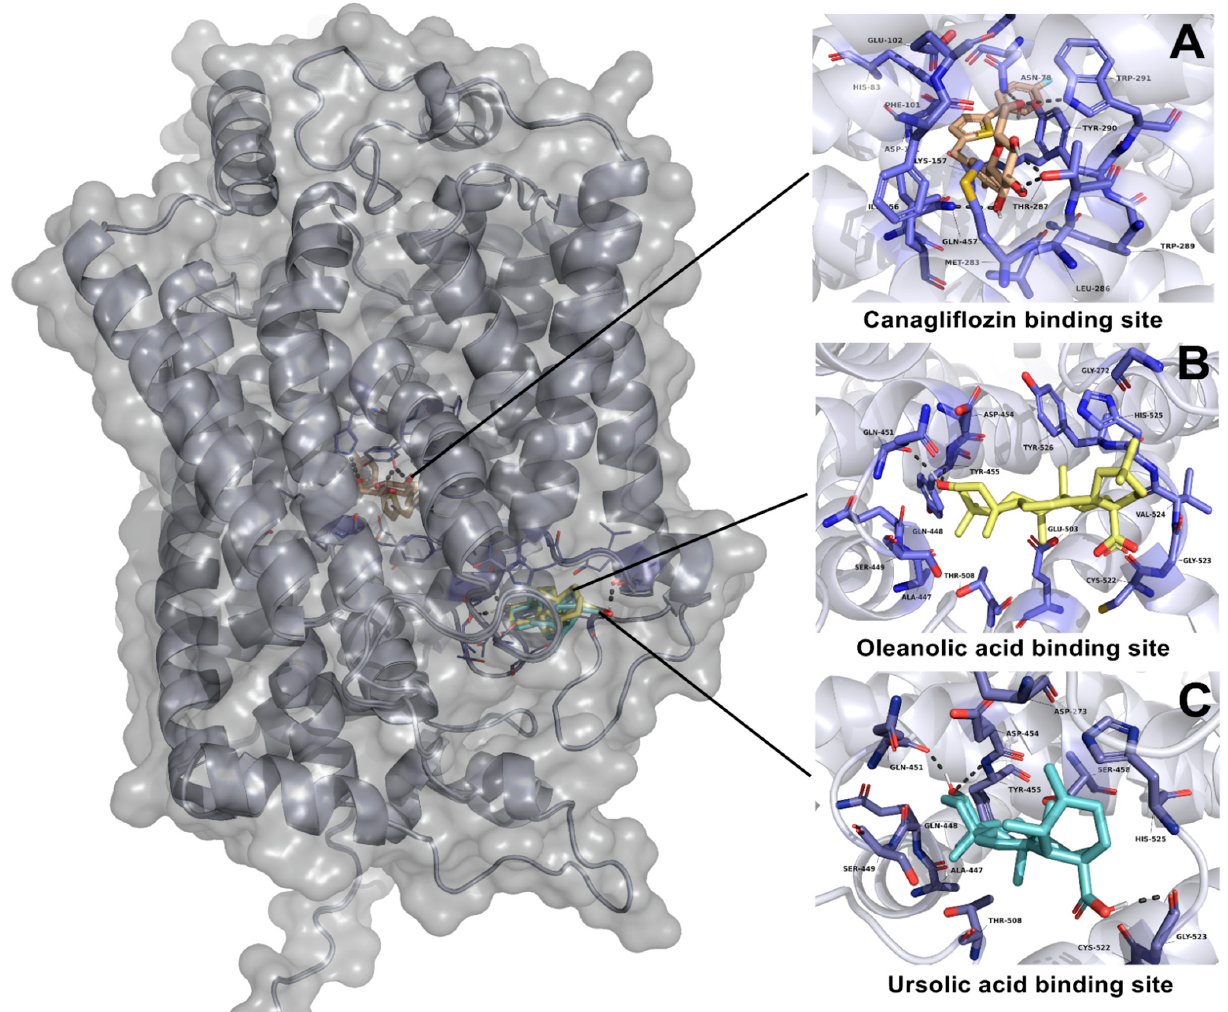
Figure 7. Results of molecular docking on SGLT1 cotransporter. ( A ) Interaction of canagliflozin and its binding site position; ( B ) interaction of oleanolic acid and its binding site position; ( C ) interaction of ursolic acid and its binding site position.